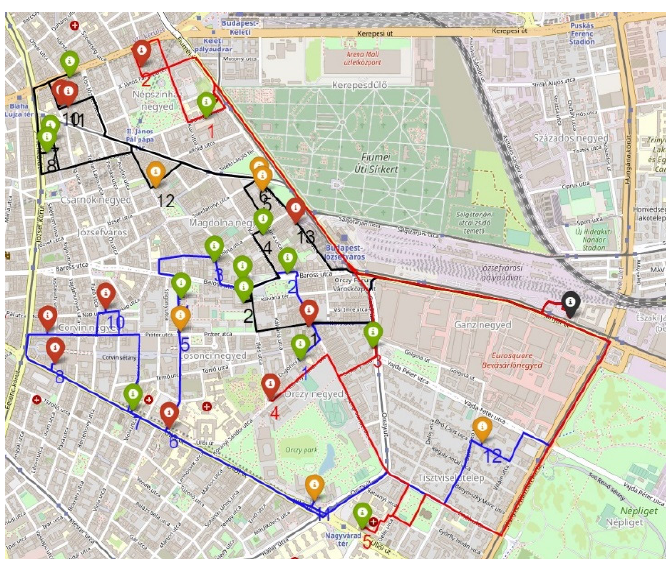
Figure 8. Actual routes when using SA. Table 6. Estimated accrued emissions in g of the case of thirty